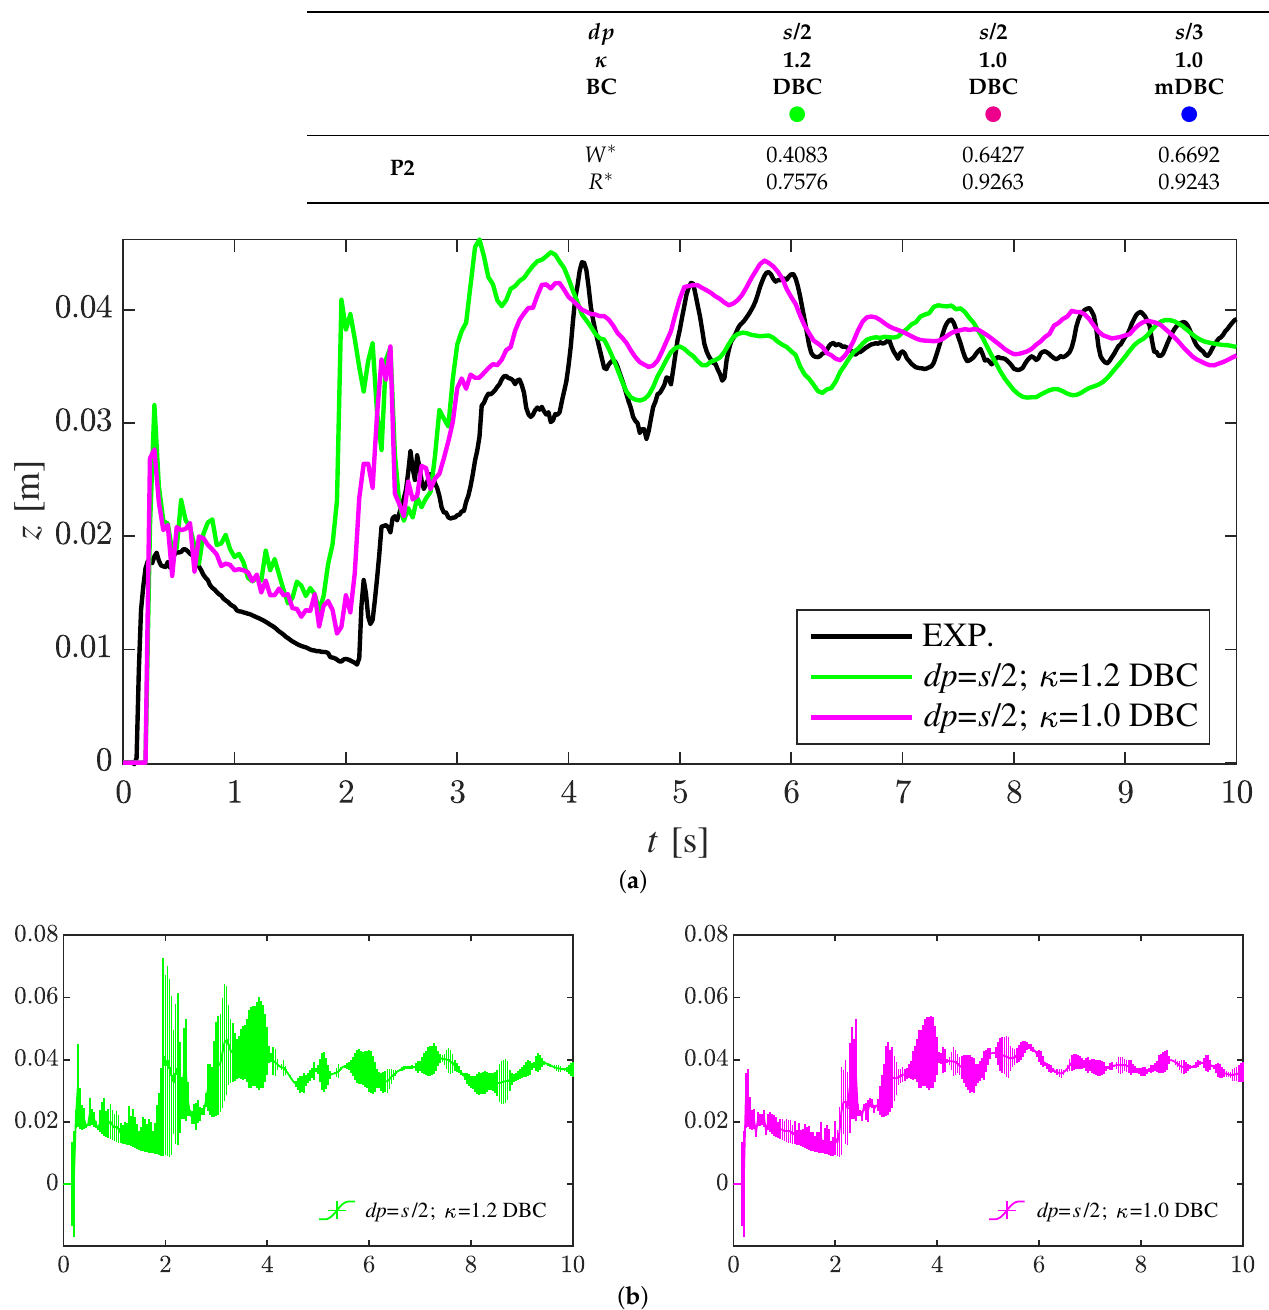
Table 2. Index of agreement and linear correlation error at P2 for three different simulations.